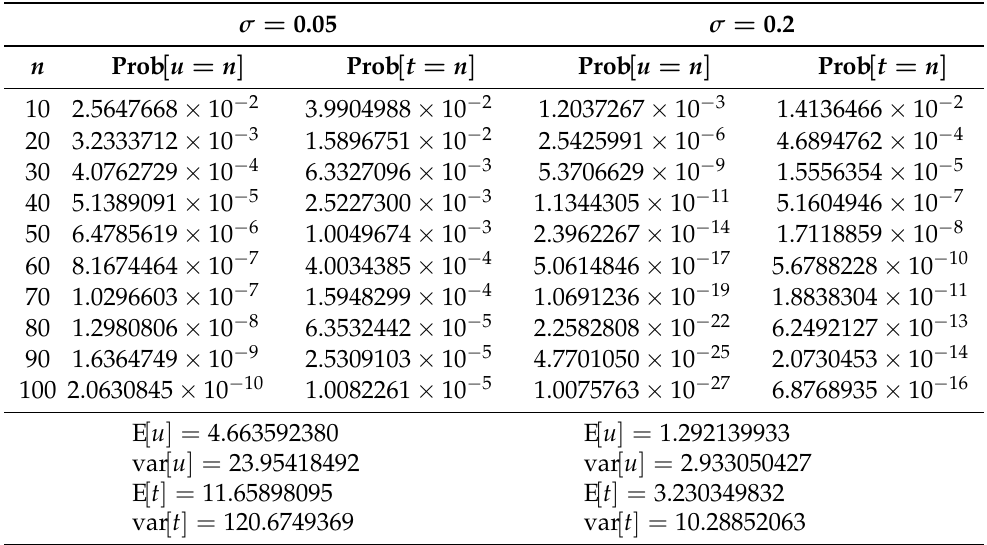
Table 1. Tail probabilities, mean and variance of the system content u and the sojourn time t for Poisson arrivals with λ = 0.4, Poisson service times with µ = 0.2 and different values of σ . σ = 0.05 σ =